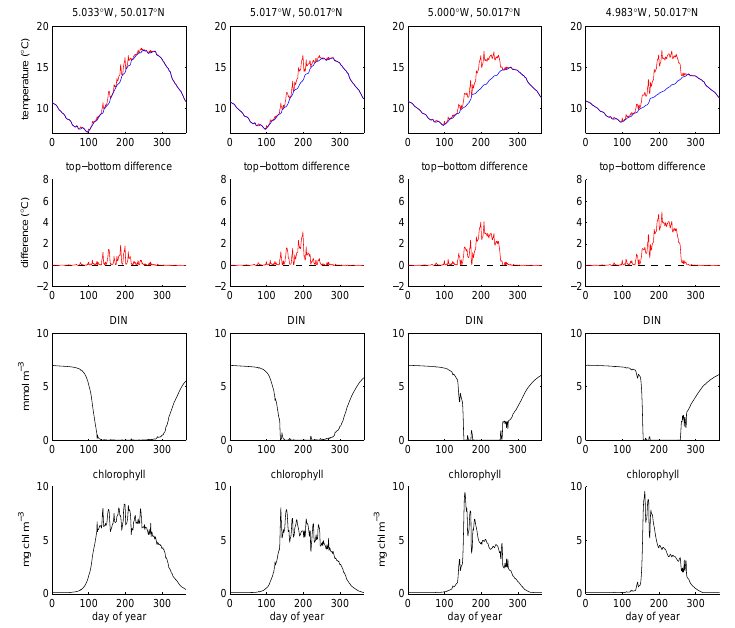
Figure 8. Time series of surface and bottom temperature (red and blue curves), surface–bottom temperature difference, surface DIN and surface chl a concentrations, across the tidal mixing front east of the Lizard peninsula in